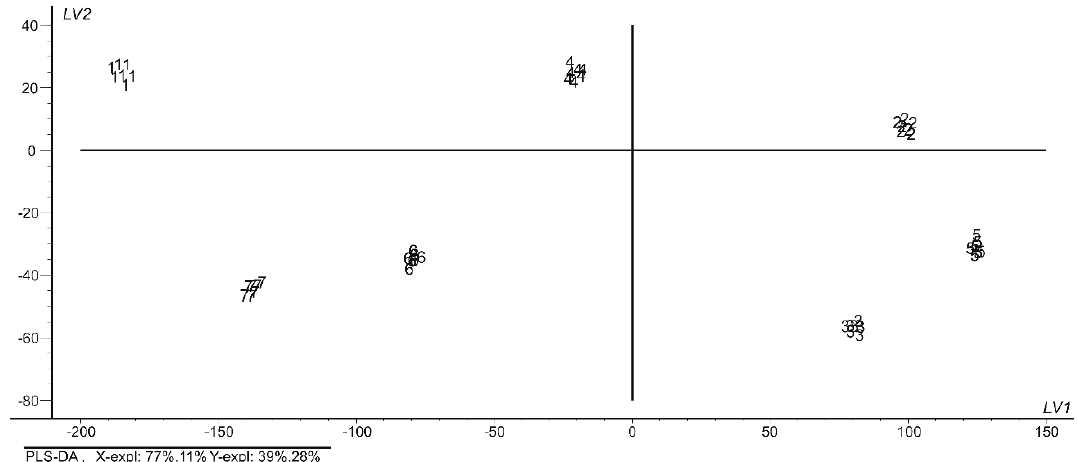
Figure 5. The partial least squares discriminant analysis (PLS-DA) scores plot.